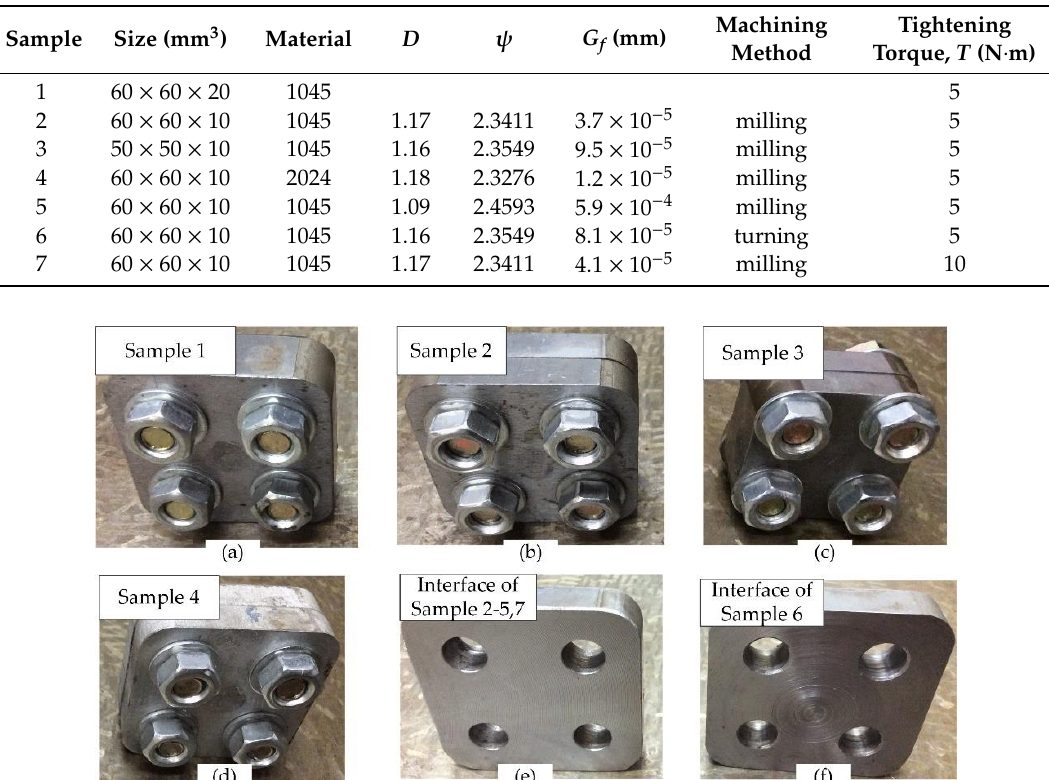
Table 3. Values of the sample variables.